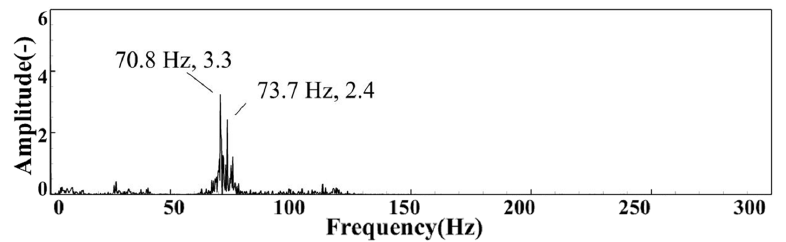
Figure 8. The spectrum of DP pulsation in the combustor under cold conditions.